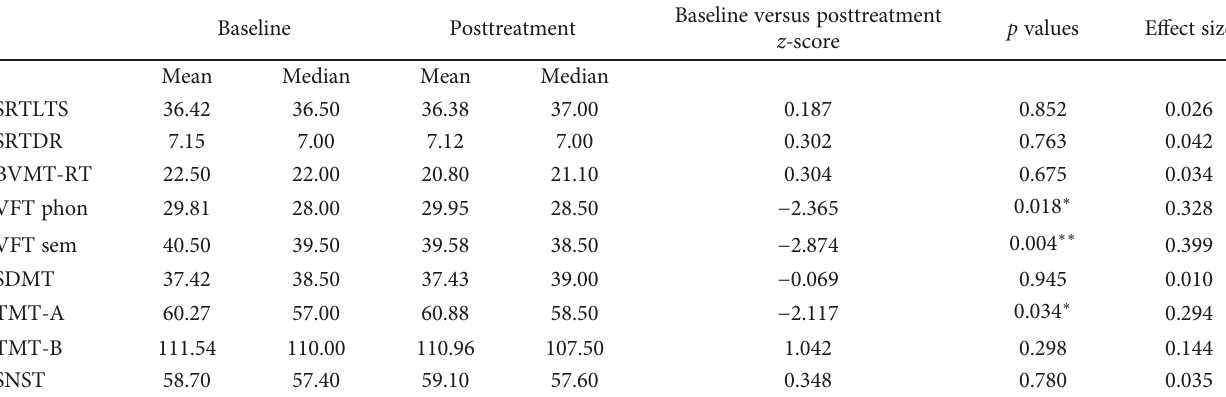
Table 5: Comparison of neuropsychological test scores for the standard care MS control group at baseline and posttreatment.